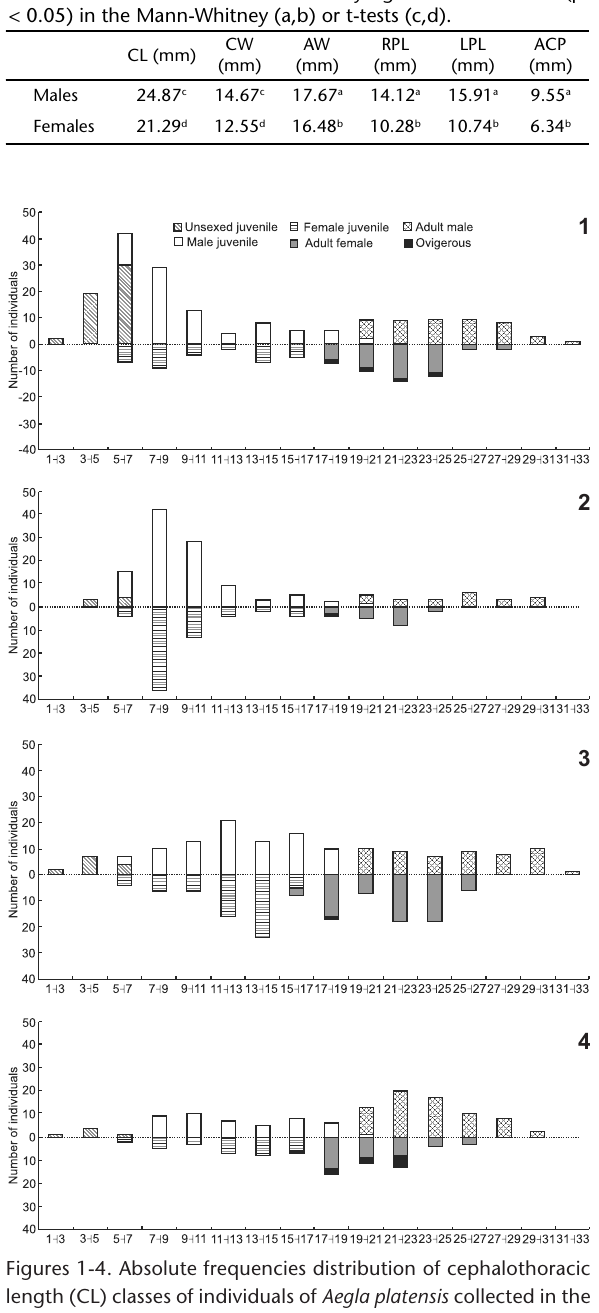
Table III. Medians of the biometric measurements (mm) of the adult individuals of Aegla platensis captured in the Lajeado Bonito stream, Uruguay Basin, Rio Grande do Sul state, Brazil. Different letters in the column indicate statistically significant differences (p